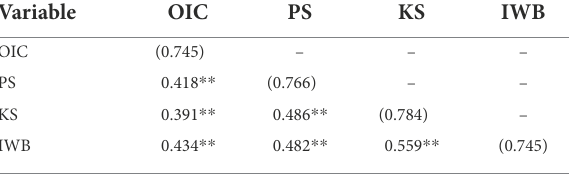
TABLE 3 Discriminant validity among